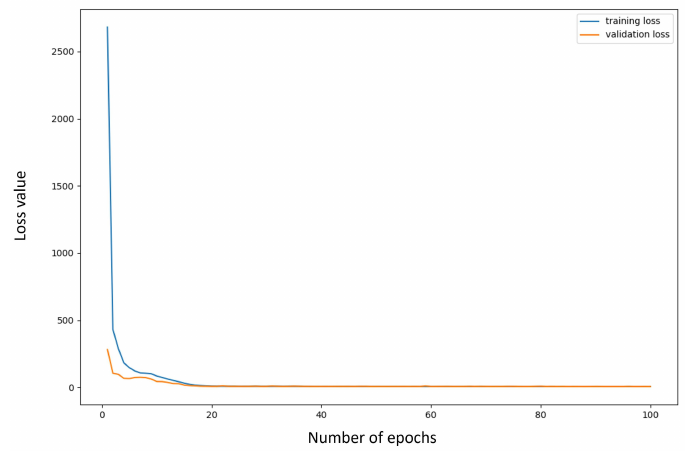
Figure 5. The loss curves of our proposed model.